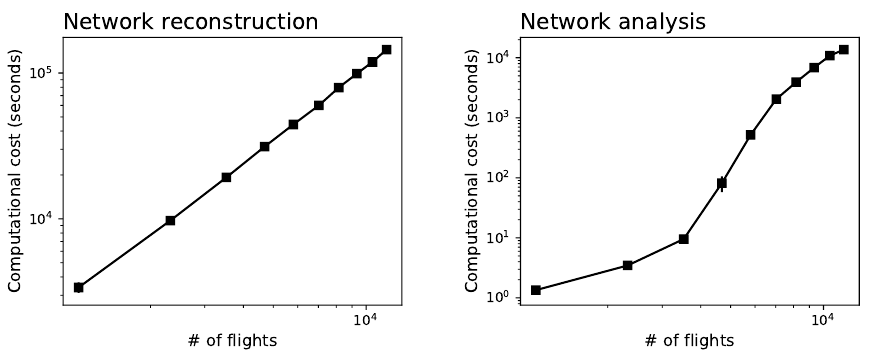
Figure A13. Computational cost. The left and right panels, respectively, depict the evolution of the computational cost (in seconds) for reconstructing the interaction network and its topological analysis, as a function of the number of flights included in it. Results have been obtained by taking the executed trajectories corresponding to 3 September 2018 (i.e., the day with the highest volume of traffic), and deleting a random part of them. Calculations have been performed on a server with AMD Epyc2 7402 processors (limited to a single core) and 64 GB of